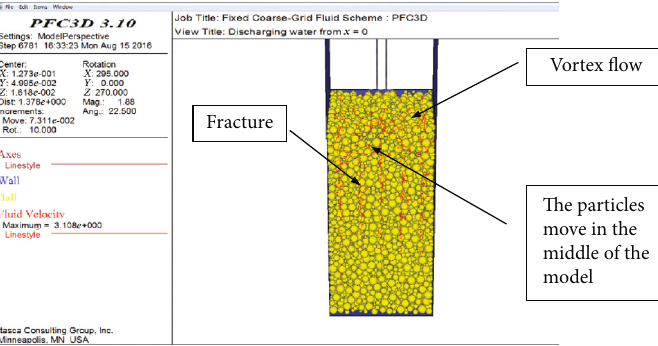
Figure 8: The vortex phenomenon and particle movement trend in the initial stage.